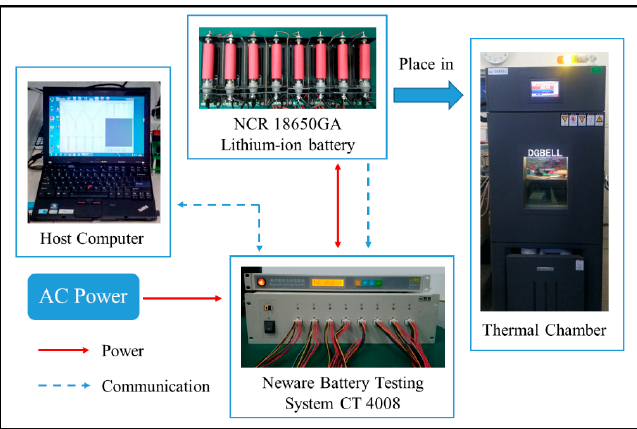
Figure 5. Schematic of the battery test bench.